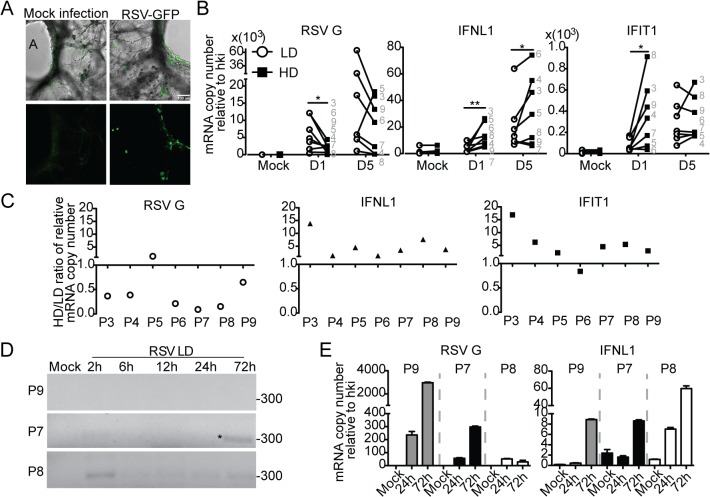
Host-intrinsic factors determine the response to iDVGs in the human lung.(A) Images of precision cut lung slices from human lungs (hPCLS) infected for 24 h with 106 RSV-GFP TCID50/slice. Top: Overlay of bright field and fluorescence channels; Bottom: fluorescence channel alone. (B) Gene expression from hPCLS infected with 107 TCID50/slice of RSV-LD or HD for up to 5 days (n = 7–8, grey numbers indicate individual lung donor). Results show paired data, numbers correspond to different donors. (*p<0.05, **p<0.01 by one-tailed Wilcoxon matched-pairs signed rank test). (C) Ratio of gene expression in RSV-HD and RSV-LD infected tissue from different donors (P3-P9). Ratio>1: HD induced a higher gene expression than LD. (D) PCR for DVGs in hPCLS infected with 106 TCID50/slice of RSV-LD. (E) Gene expression from (D). Error bars indicate mean ± SEM of three slices from the same patient.